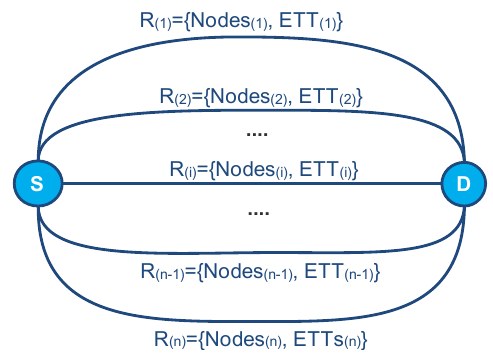
Figur e 6. The set of candidate